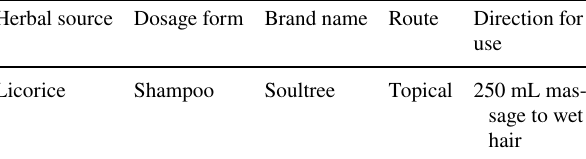
Table 10 Market formulation for Licorice Herbal source Dosage form Brand name Route